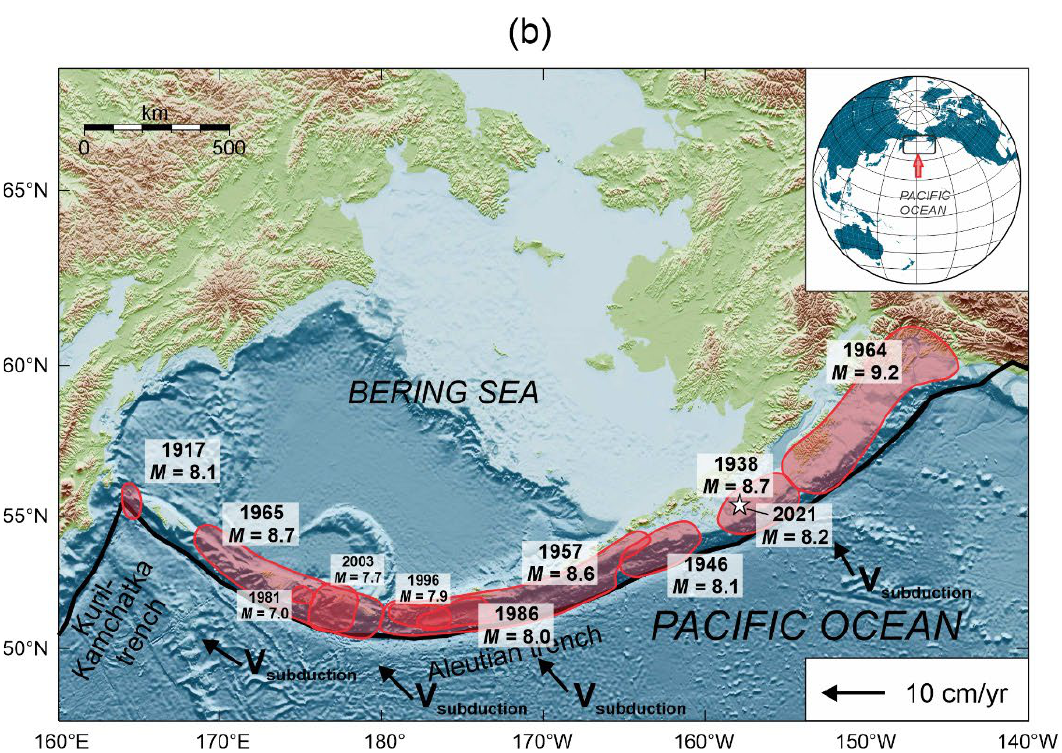
Figure 1. ( a ) Regional seismicity map based on USGS catalog data (M > 4.5) [28]. The largest regional earthquakes (M ≥ 8) are denoted by white circles; ( b ) location of fault zones of the megathrust earthquakes in Alaska and the Aleutian island arc [29,36–38]. 1—subduction rates relative to the North American lithospheric plate (arrow scale is 10 cm/yr).